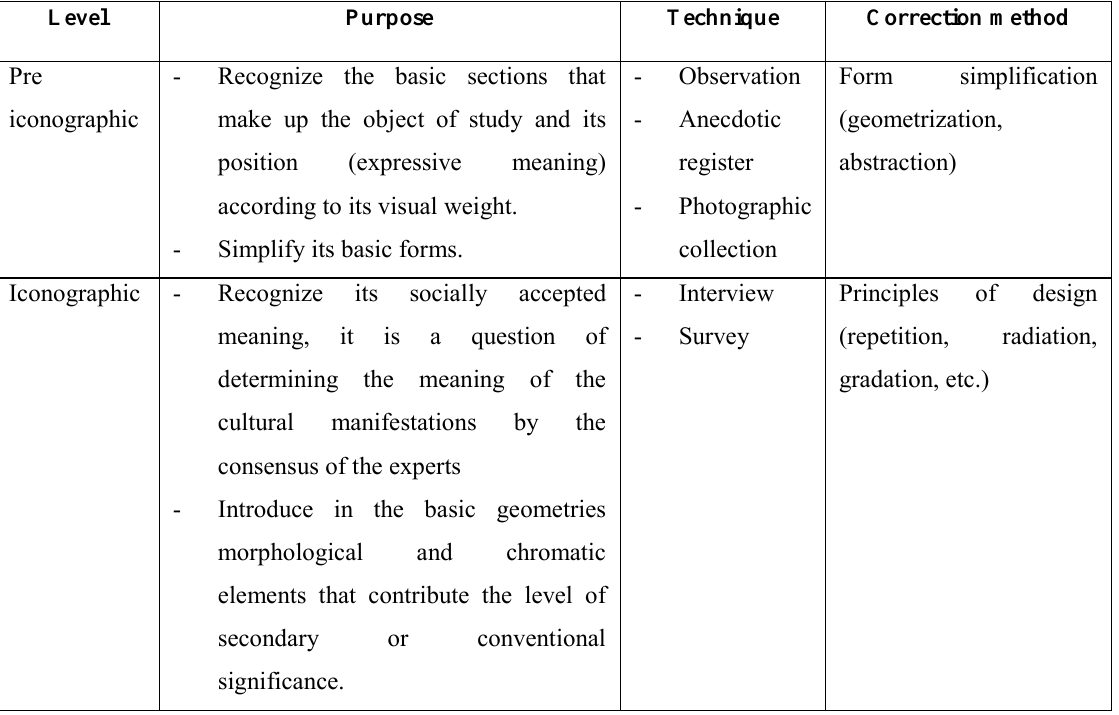
Table 2. Levels of